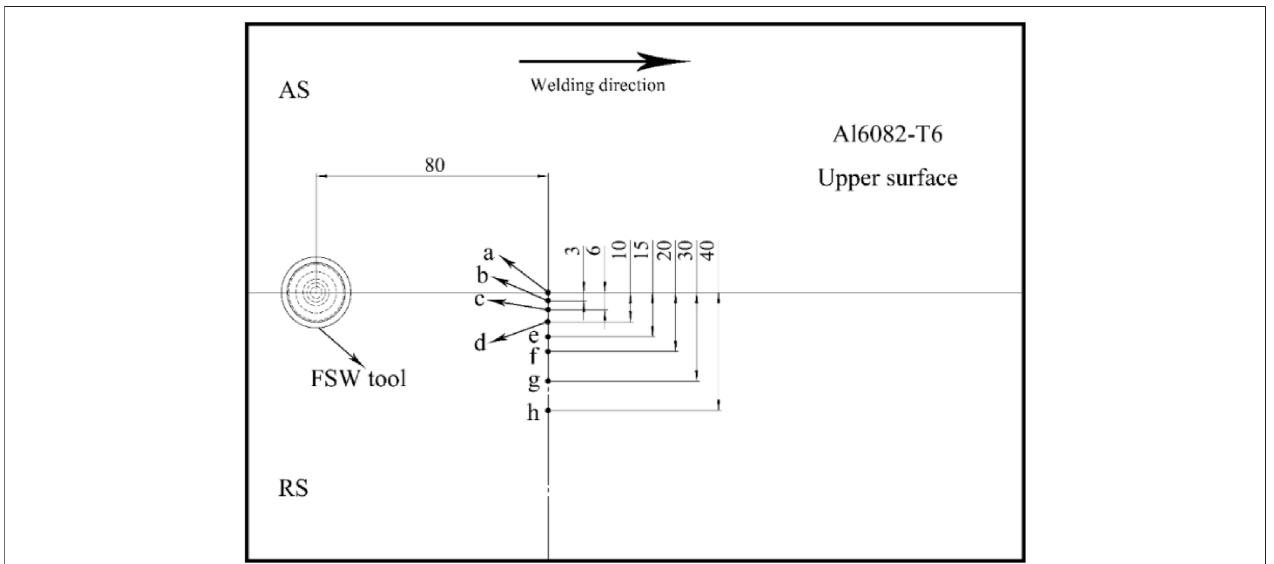
FIGURE 7 | Distribution of feature points on the upper surface of the workpiece.